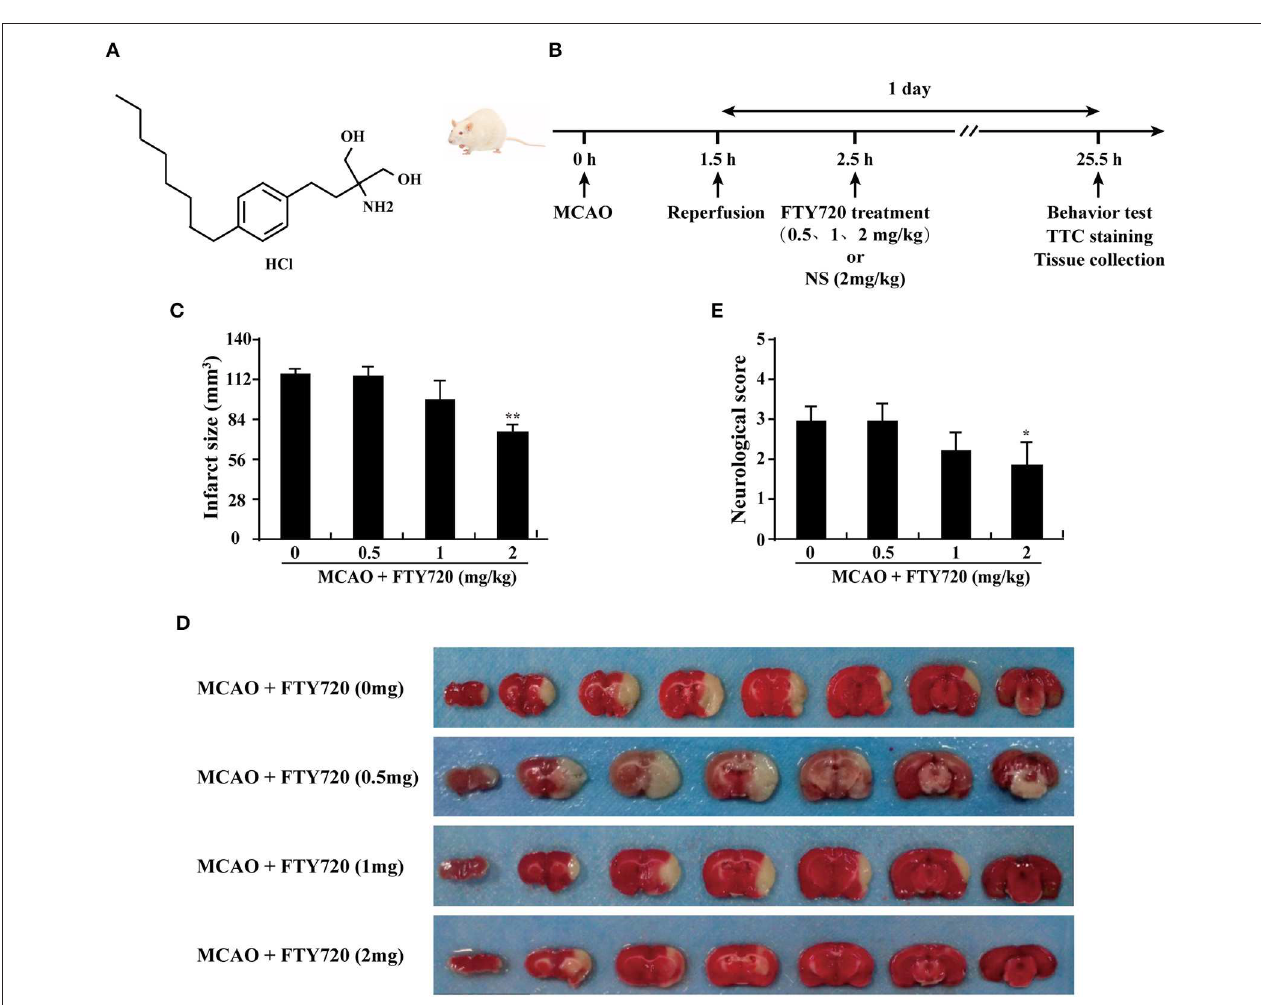
FIGURE 1 | FTY720 treatment prevents MCAO-induced brain injury and neurological dysfunction in rats. (A) The chemical structure of FTY720. (B) Experimental procedure for in vivo experiments. Stroke was induced in rats with transient occlusion of the MCAO. FTY720 was intraperitoneally injected at 0.5, 1, and 2 mg/kg/day after ischemia/reperfusion. One day after ischemia/reperfusion, the all experiments were carried out. (C) Quantification of neurological function scores at 1 day after focal ischemia. FTY720 treatment improved neurological functions. n ≥ 8 per group. * p < 0.05, compared to the MCAO group, by one-way ANOVA and Tukey’s test. (D) FTY720 (2 mg/kg) treatment significantly reduced infarct volume. Representative brain slices with infarcts stained by triphenyl tetrazolium chloride from each group at 1 day after MCAO. (E) Quantification of infarct volume at 1 day in MCAO rats with or without FTY720. n ≥ 8 per group. ** p < 0.01, compared to the MCAO group, by one-way ANOVA and Tukey’s test. All data are presented as means ±